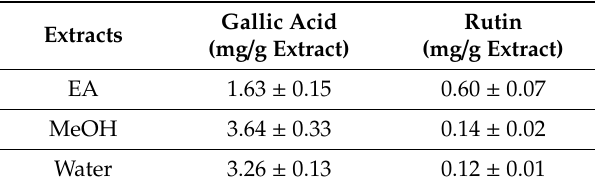
Table 2. Gallic acid and rutin levels in B. abyssinica extracts.